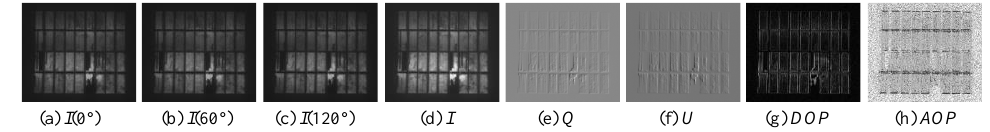
Figure 6. SWIR Polarization Image of polycrystalline silicon solar panel.